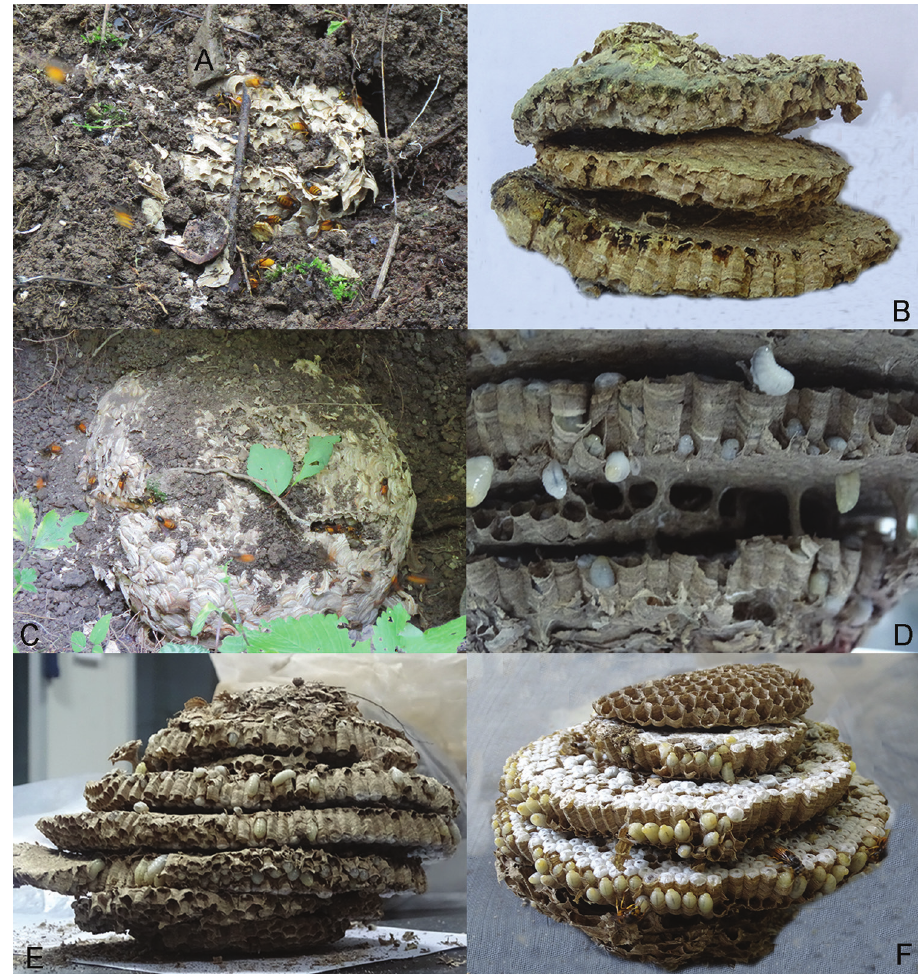
Figure 1. Vespula structor (Smith). A–B Nest from Xunyangba C–F Nest from Baoji: C Site of nest; combs of nest D–F combs of nest, lateral